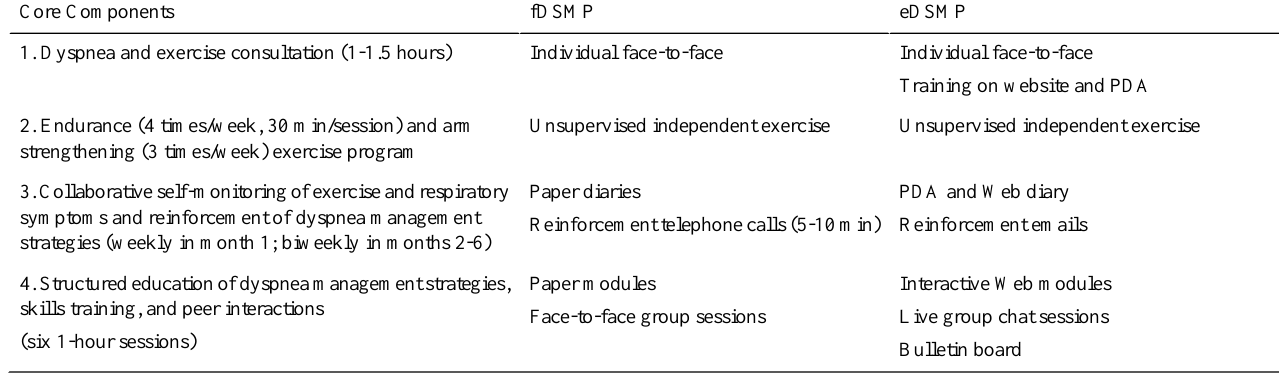
Table 1. Dyspnea self-management program components